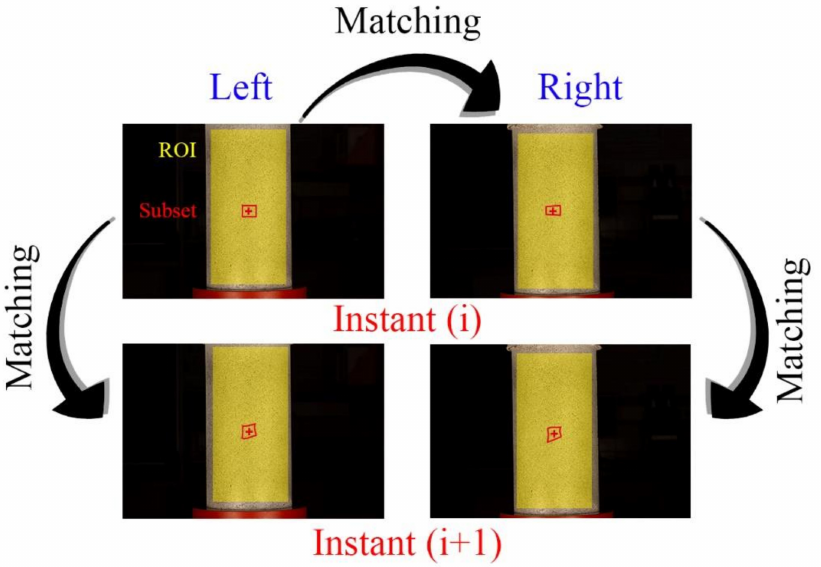
Figure 6. Image registration in 3D-DIC